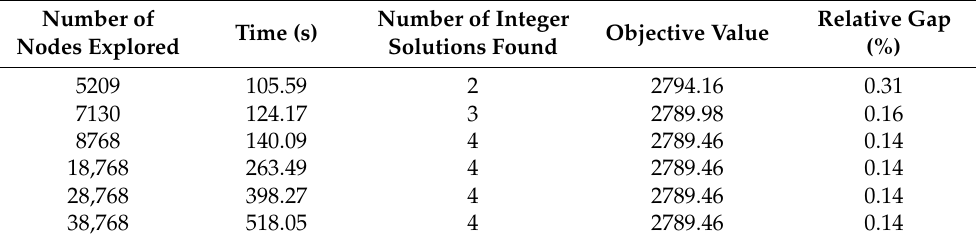
Table 4. Converging results obtained for the parcel locker location problem with Γ = 20.